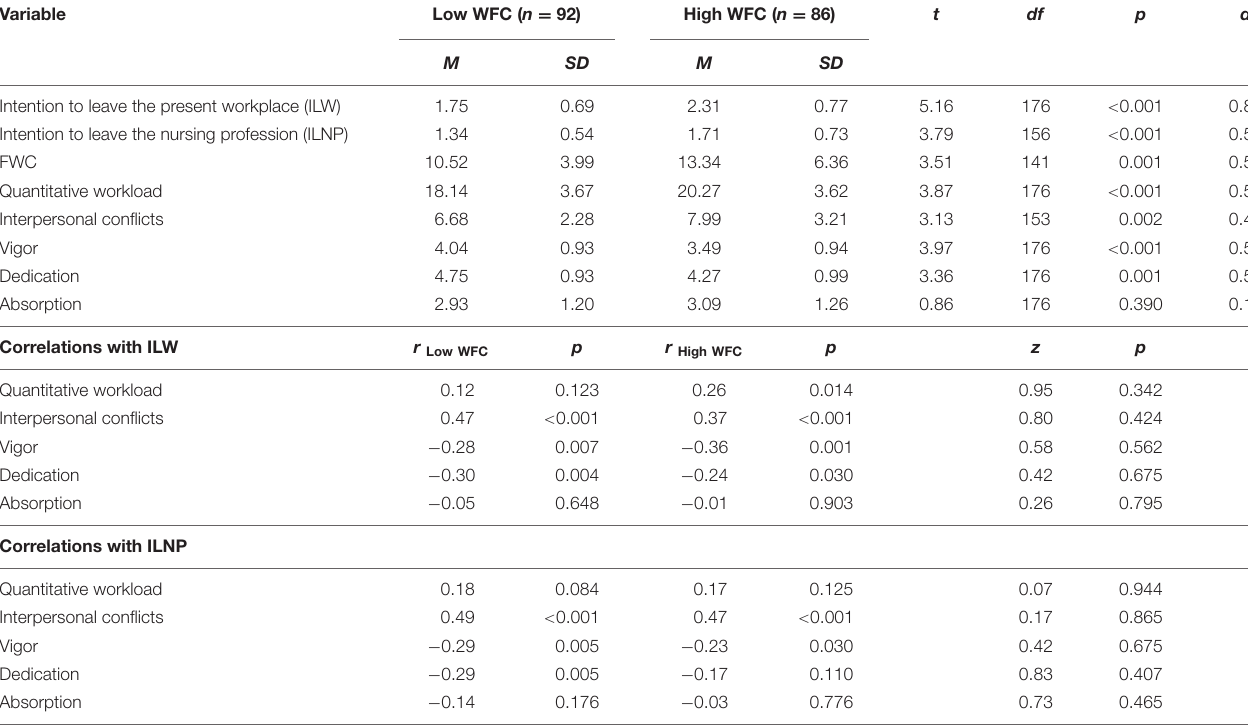
TABLE 5 | Comparisons between nurses with low and high values of work-family conflict (WFC).